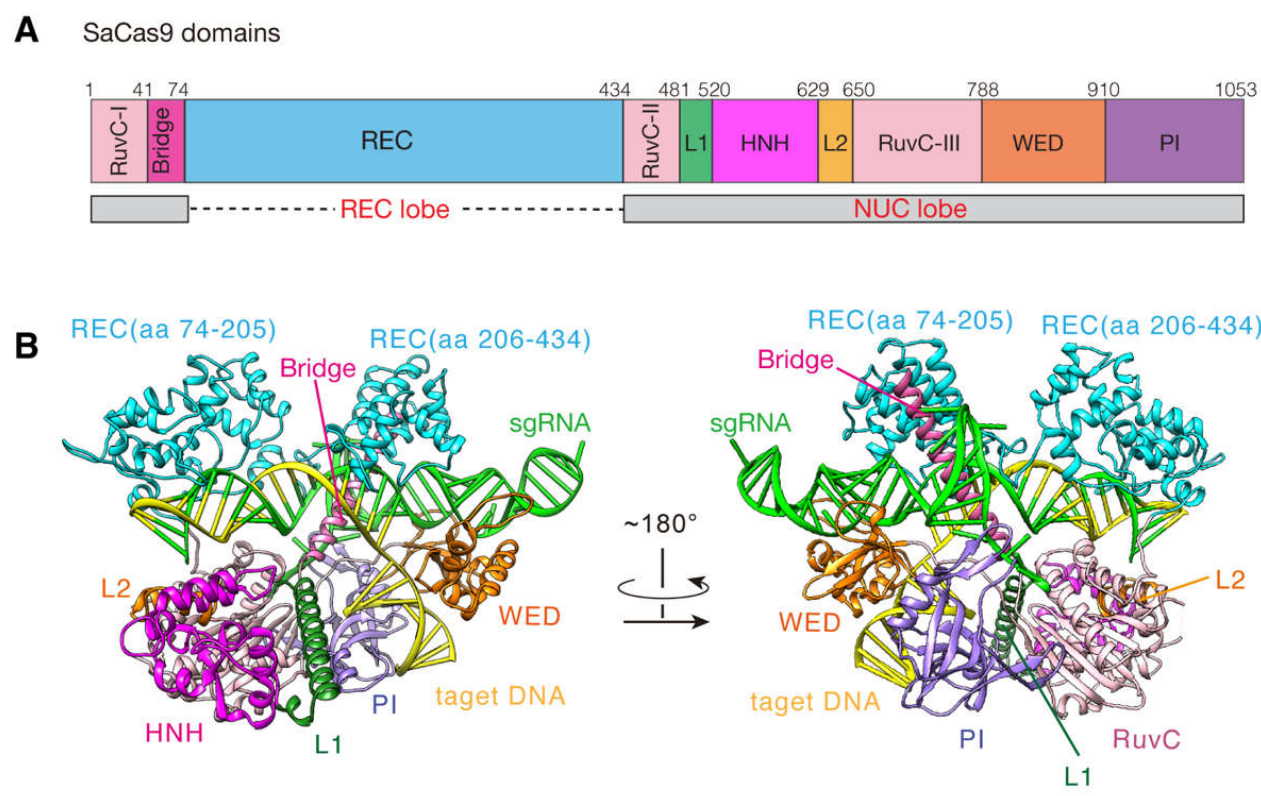
Figure 1. The structural domains of the SaCas9-sgRNA-target DNA complex. ( A ) Domain organization of SaCas9. ( B ) Ribbon representations of the complex structure in inactive state (PDB ID 5CZZ). The REC, RuvC-I~III, HNH, L1, L2, WED, PI and Bridge domains are colored in cyan, light pink, pink, dark green, orange, brown, purple and rose red, respectively. The sgRNA is colored in green; the target DNA is colored in yellow.